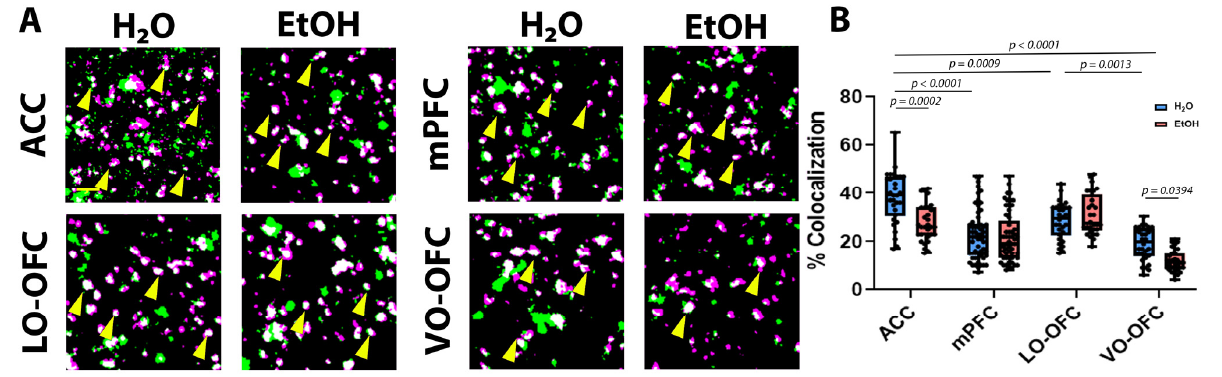
Figure 5. The effect of AIE on neurexin-neuroligin 1 interactions after a 26-day forced abstinence period. We found that AIE did not change neurexin or neuroligin 1 expression following a 26-day forced abstinence period (see supplemental data). ( A ) Representative images of neurexin (green) and neuroligin 1 (magenta) in the ACC, mPFC (IL and PL), LO-OFC, and VO-OFC. Scale bar, 2 μ m. ( B ) Quantification of neurexin and neuroligin 1 co-localization. There was a significant decrease in neurexin-neuroligin 1 co-localization in the ACC ( p = 0.0002) and the VO-OFC ( p = 0.0394) following AIE. Data presented as box and whisker plots with interquartile range with mean, minimum, and maximum measures indicated along with individual data points. Three 5 μ m image stacks from randomly selected hemispheres were captured from 3 separate brain slices per animal (n = 9–10 brains/treatment group). Analysis: two-way ANOVA with Tukey’s post hoc comparison. fect (F (3, 286) = 6.664, p = 0.0103), subregion effect (F (3, 286) = 19.97, p < 0.0001), and a